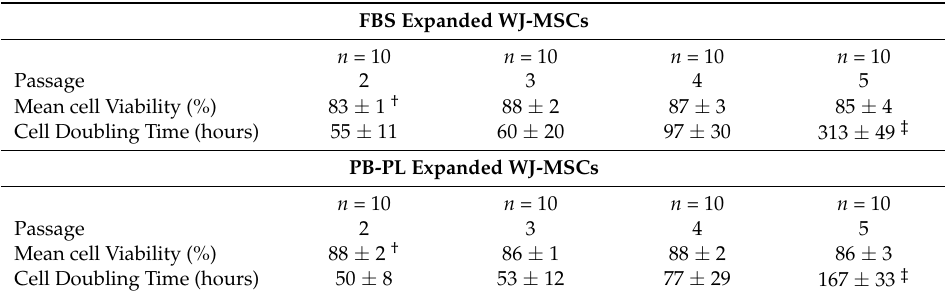
Figure 3. Cell doubling time of WJ-MSCs treated with FBS and PB-PL growth medium. At passage 5, the WJ-MSCs treated with PB-PL growth medium showed statistical significant reduction in CDT, compared to FBS expanded WJ-MSCs. The significance of the difference between the FBS and PB-PL treated WJ-MSCs at passage 5 is represented: ** p < 0.01.